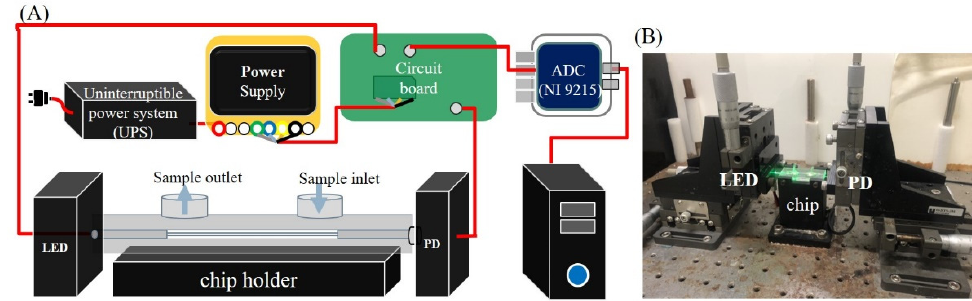
Figure 2. ( A ) Schematic illustration of the experimental setup used for the biosensing system. ( B ) A photograph of the setup.